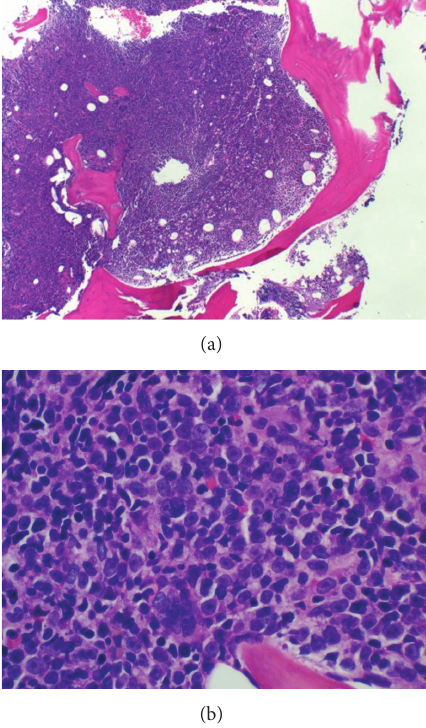
Figure 1: (a) Bone marrow biopsy, H&E stain, 4x image showing hypercellular marrow. (b) Bone marrow biopsy, 40x image showing large cells with prominent nucleoli.